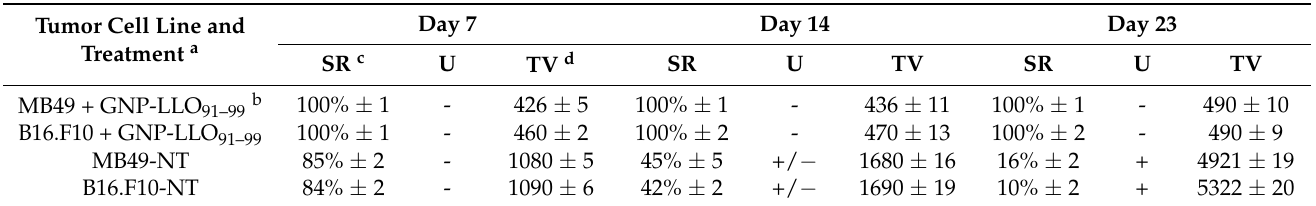
Table 2. Clinical parameters of mice transplanted with melanoma and bladder tumors after GNP- LLO 91–99 therapy.